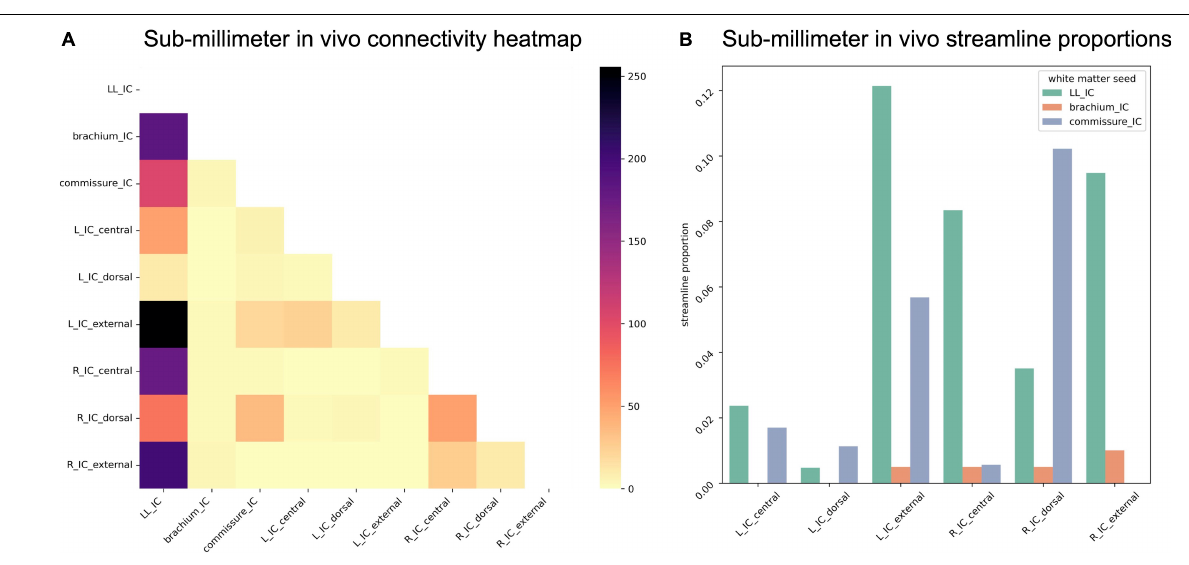
FIGURE 9 | (A) Connectivity matrix of sub-millimeter in vivo inferior colliculus (IC) subdivisions and adjacent white matter tracts (values indicate number of streamlines); (B) proportion of streamlines reaching each white matter region for each IC